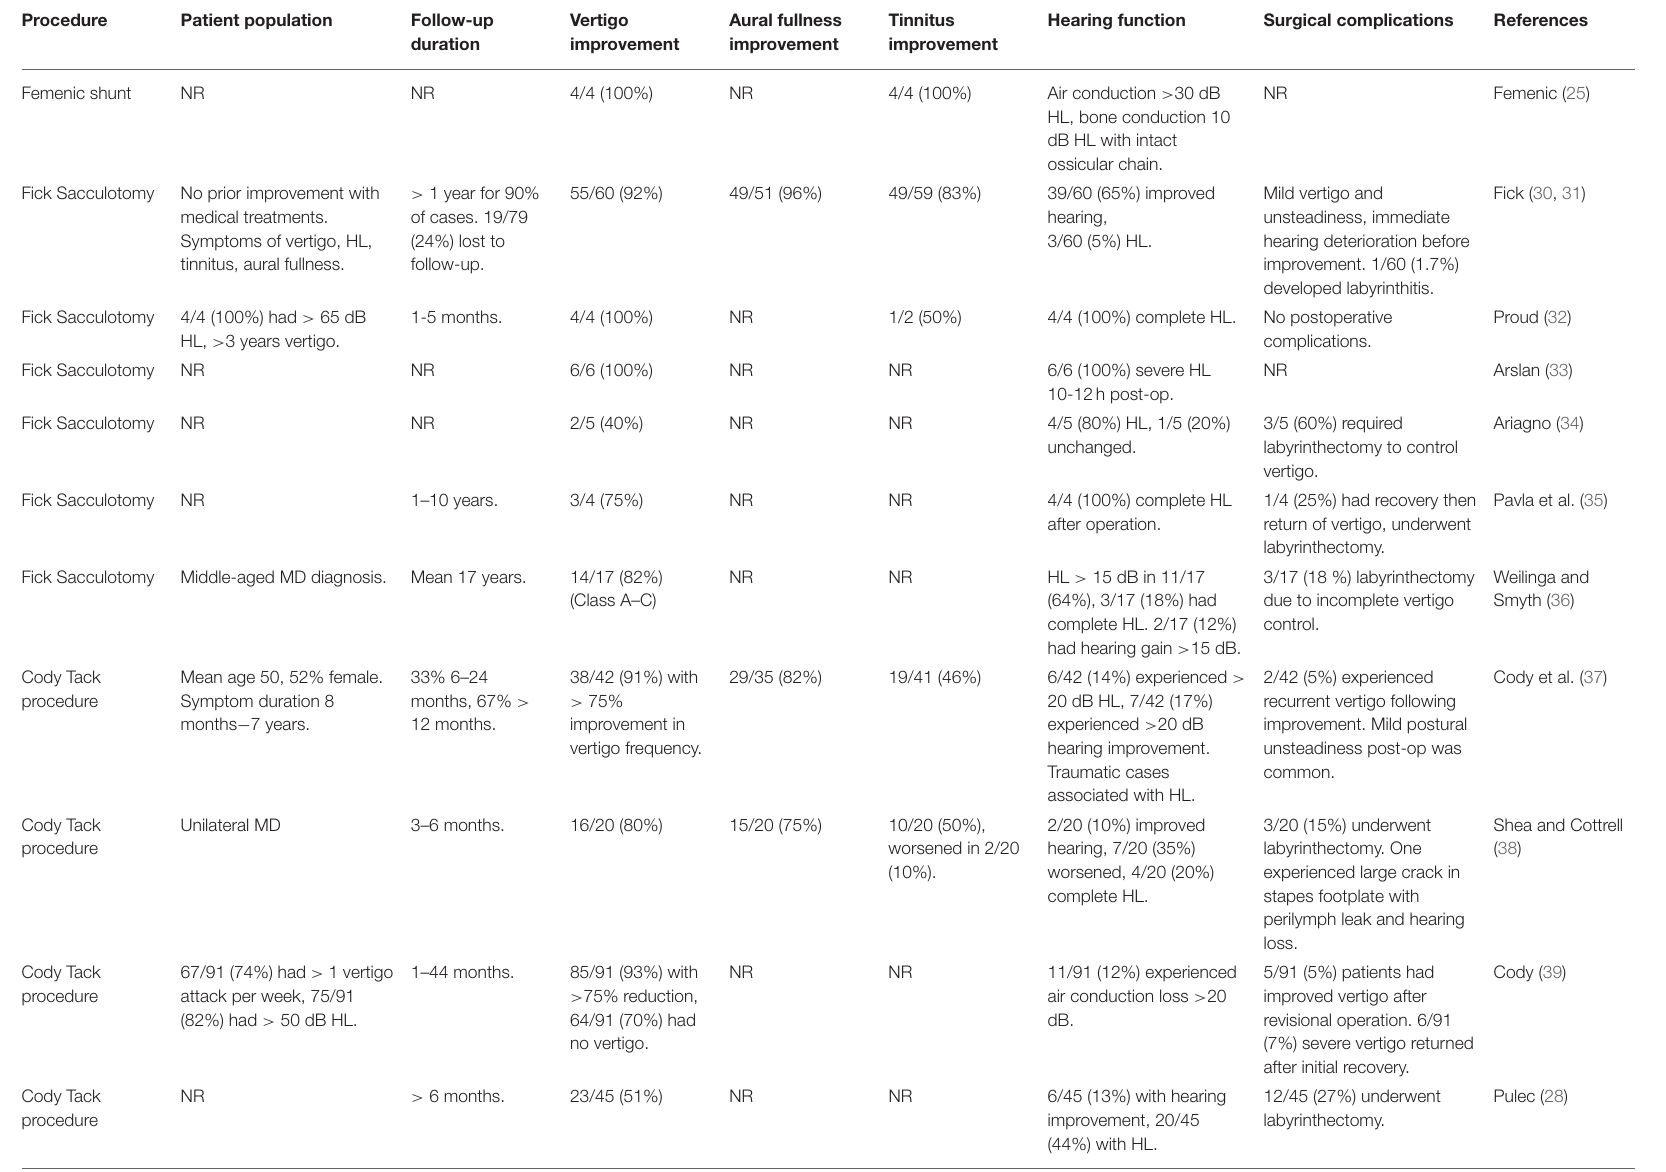
TABLE 1 | Historical and present outcomes of surgical procedures on the membranous labyrinth for control of vertigo and other symptoms in Meniere’s